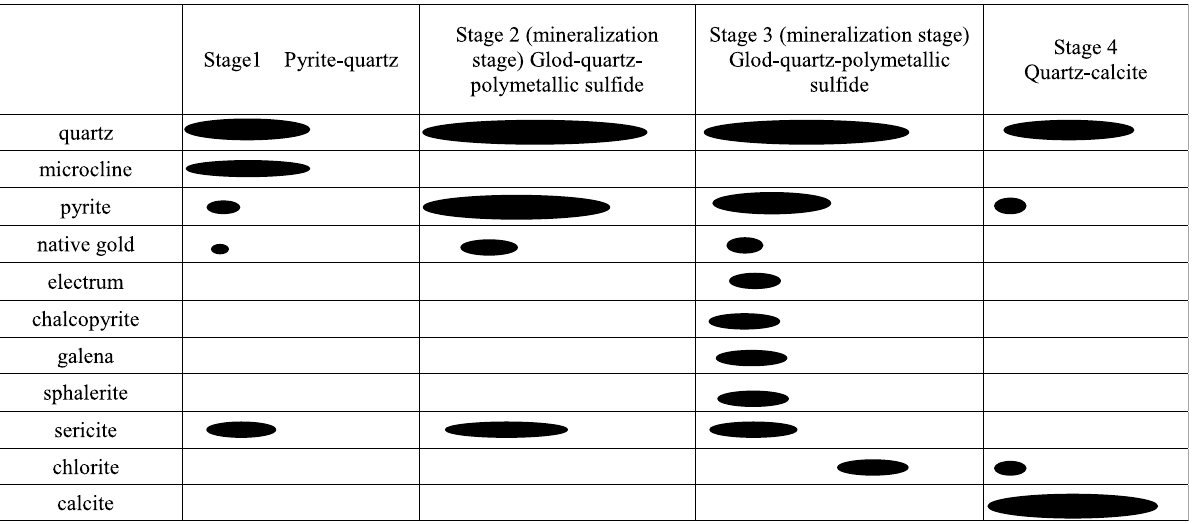
TABLE 1 Paragenetic sequence of minerals for the Dongtongyu gold